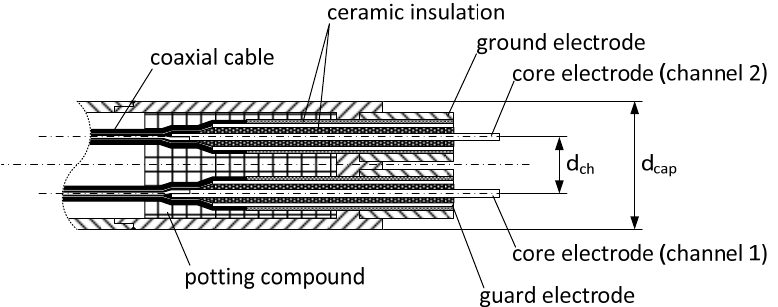
Figure 2. Schematic of a two-channel capacitance probe with a distance d ch between the channels and a total diameter of d cap .